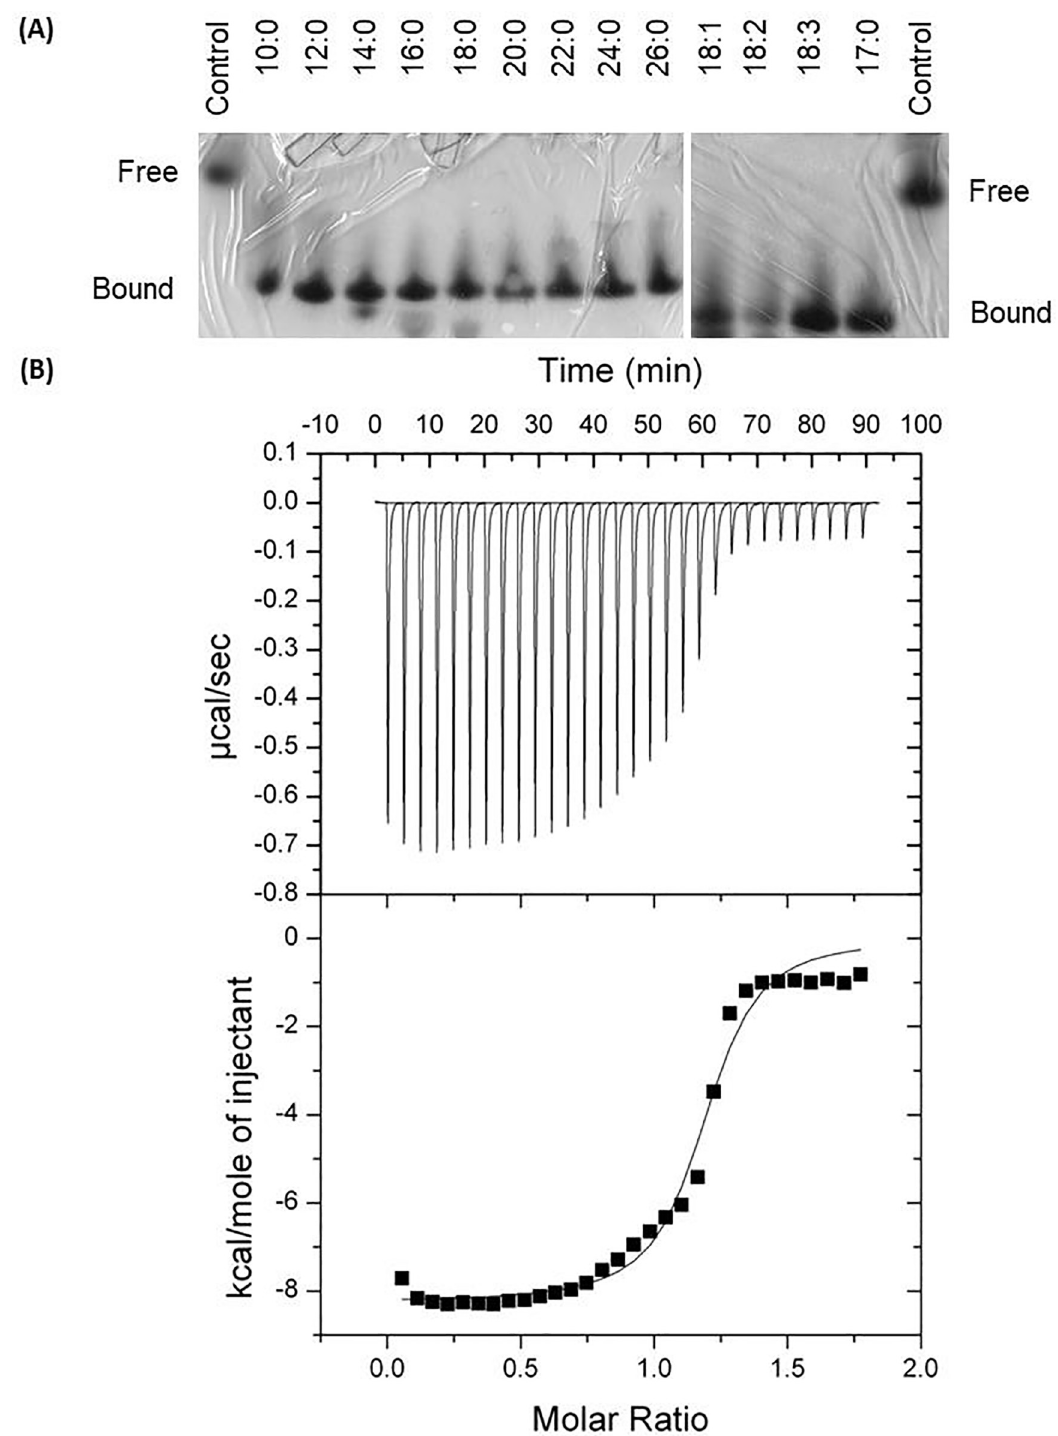
Fig 3. RpACBP-5 binds acyl-CoA in vitro . (A) The purified recombinant RpACBP-5 was added to the acyl-CoA and binding buffer and then subjected to a native polyacrylamide gel electrophoresis. Controls did not receive acyl-CoA. Numbers indicate the size of the fatty acid carbon chain followed by the number of unsaturations, present on the tested acyl-CoA. The images are representative of two experiments. (B) Lauroyl-CoA binding to RpACBP-5 was analyzed in microcalorimeter equilibrated at 27˚C. Protein (25 μ M) was placed in the calorimeter chamber and titrated with 0.5 mM lauroyl-CoA, in binding buffer. There were 30 injections of 4 μ l every 180 seconds. A representative result of five experiments is shown.